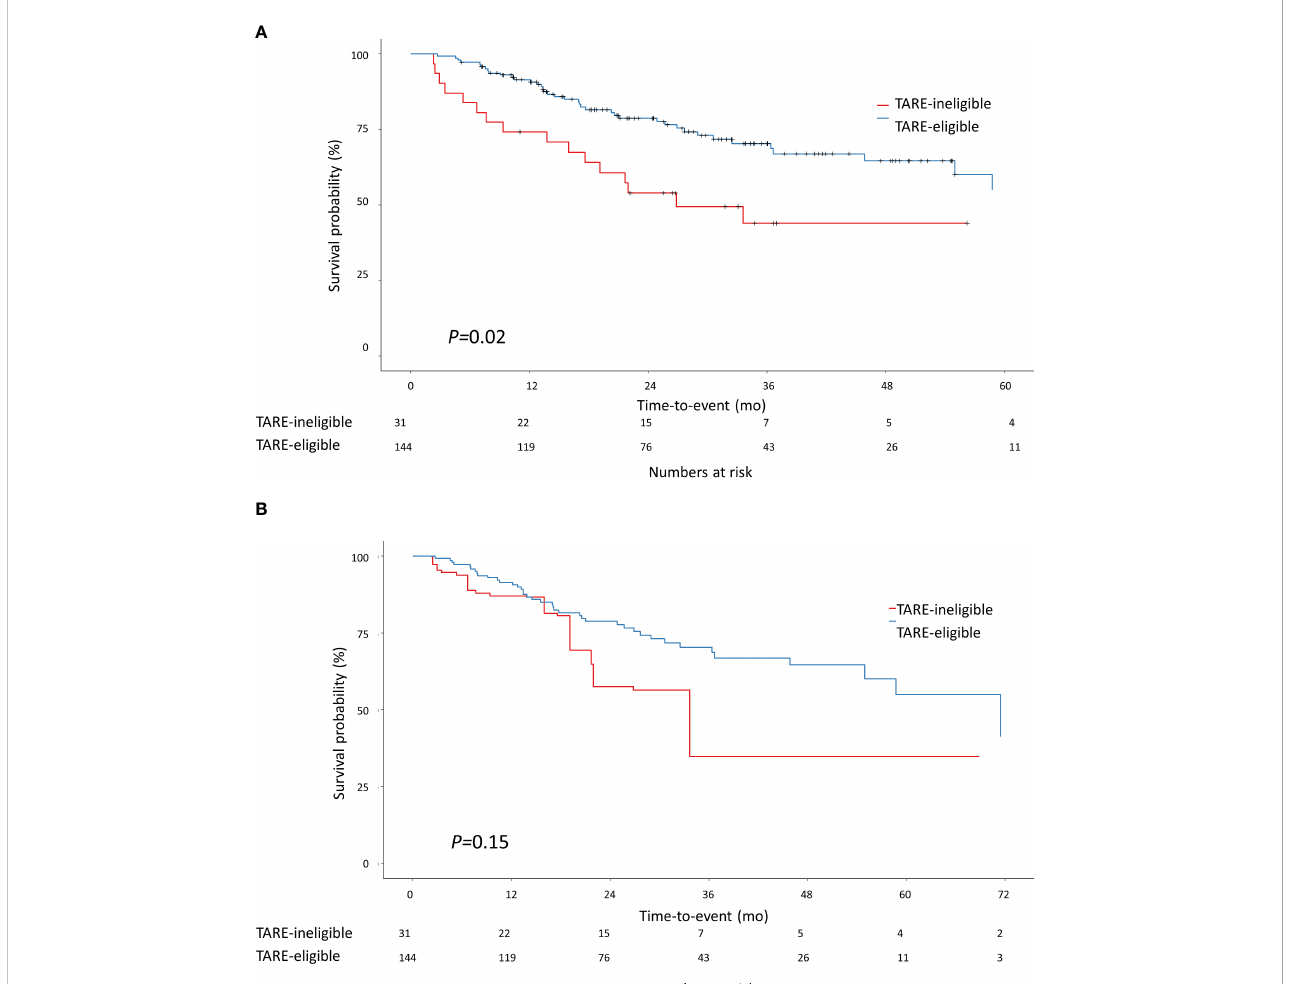
FIGURE 3 Kaplan-Meier methodology was used to estimate overall survival between the TARE-eligible and TARE-ineligible groups (A) before applying IPTW and (B) after applying IPTW. Propensity score for IPTW were computed using the following variables: tumor size, MoRAL score, Child-Pugh class, and BCLC